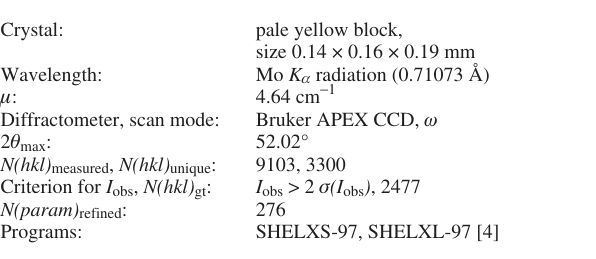
Table 1. Data collection and handling.